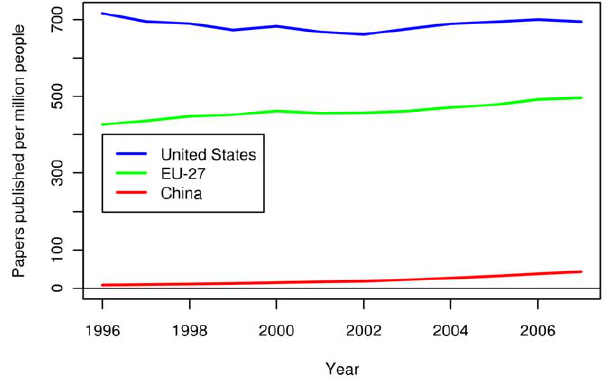
Figure 12. Per capita triadic patents granted in the US, the EU- 27 and China. The blue, green, and red lines show the number of triadic patents granted per capita to American (US), European (within the EU-27), and Chinese inventors, respectively. Per capita figures were divided by the population of the region.